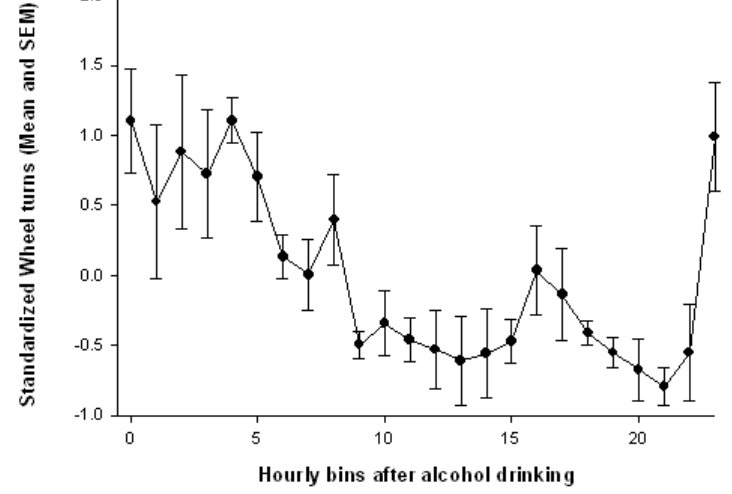
FIGURE 3 . Standardized wheel turns (Mean ± SEM) for eight rats given 1-h access to a 10% ethanol/water solution at 24-h intervals on 25 days. This study used HAD (High Alcohol Drinking) rats, selectively bred for high intake of ethanol. Access was given during hour 0, and stimulated wheel running for 5–6 during and after the drinking period. The rats were housed without time-of-day cues, under constant dim lighting, and with rate-limited feeding. Circadian anticipatory wheel running can be seen at hour 23, 1 h before the next access